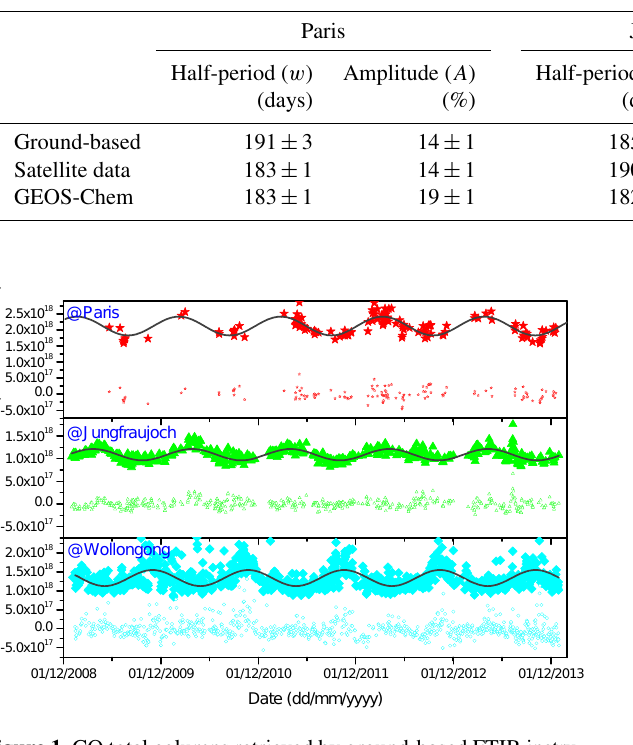
Figure 1. CO total columns retrieved by ground-based FTIR instru- ments at Paris (top), Jungfraujoch (middle) and Wollongong (bot- tom). Dark grey lines present CO seasonal variability at each sta- tion fitted with sine functions; open symbols represent the residuals from the sine fit.